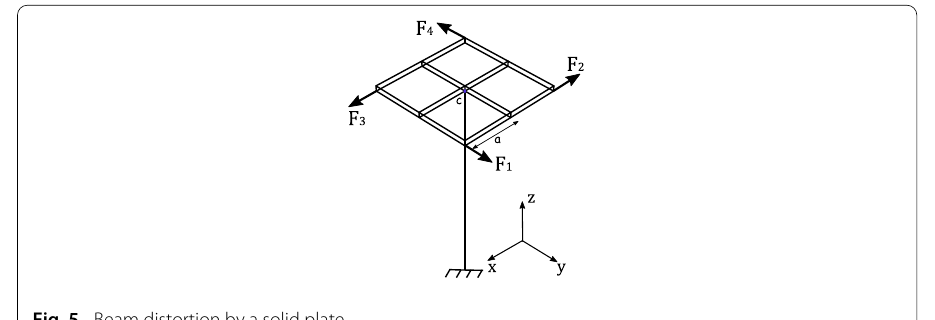
Fig. 5 Beam distortion by a solid plate